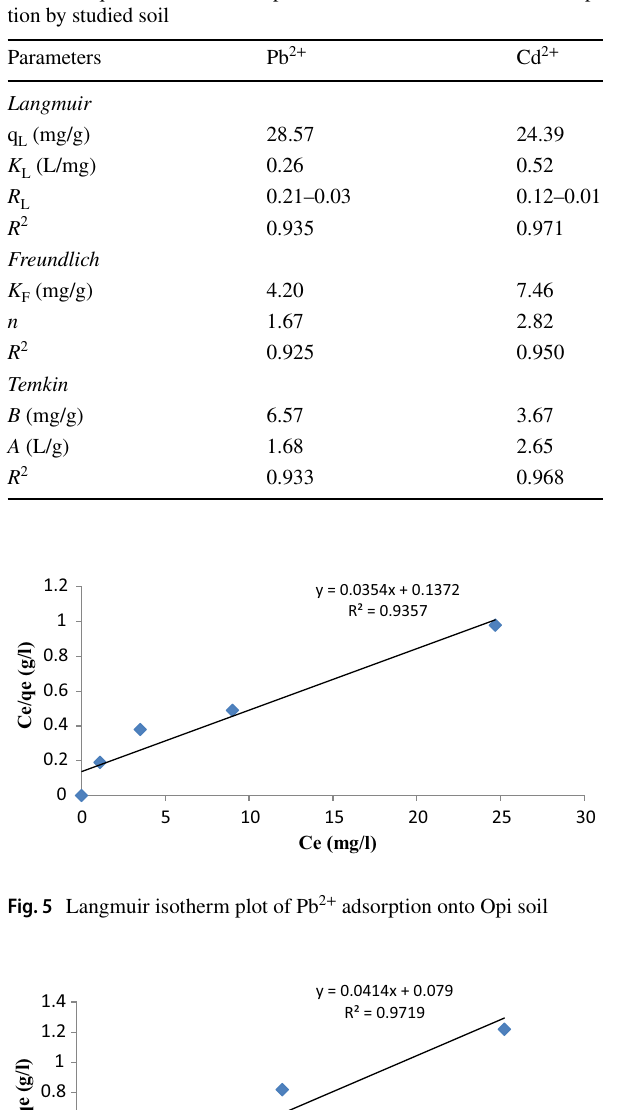
Table 3 Kinetic model parameters for Pb 2+ and Cd 2+ adsorption by